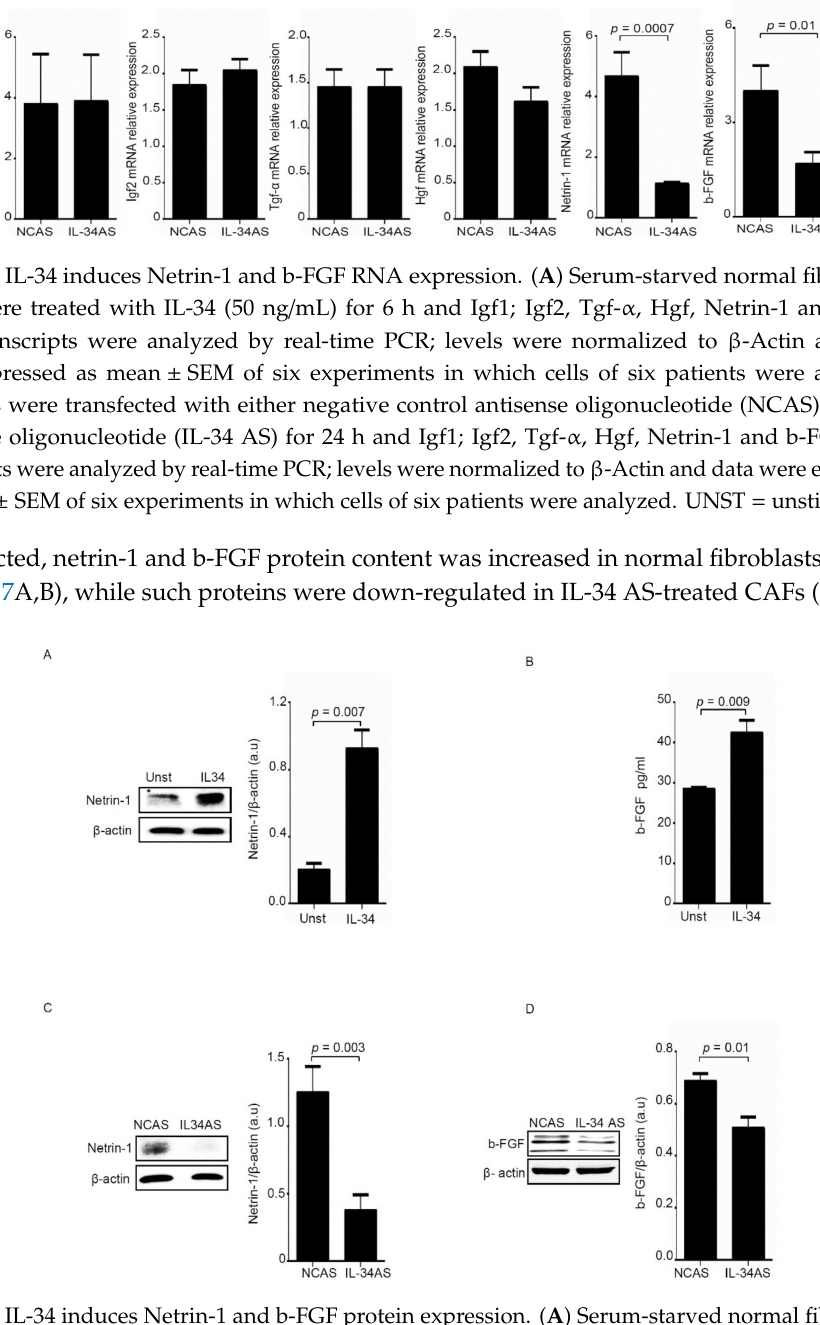
Figure 7. IL-34 induces Netrin-1 and b-FGF protein expression. ( A ) Serum-starved normal fibroblasts (NFs) were treated with IL-34 (50 ng / mL) for 24 h. Netrin-1 and β -Actin were evaluated by